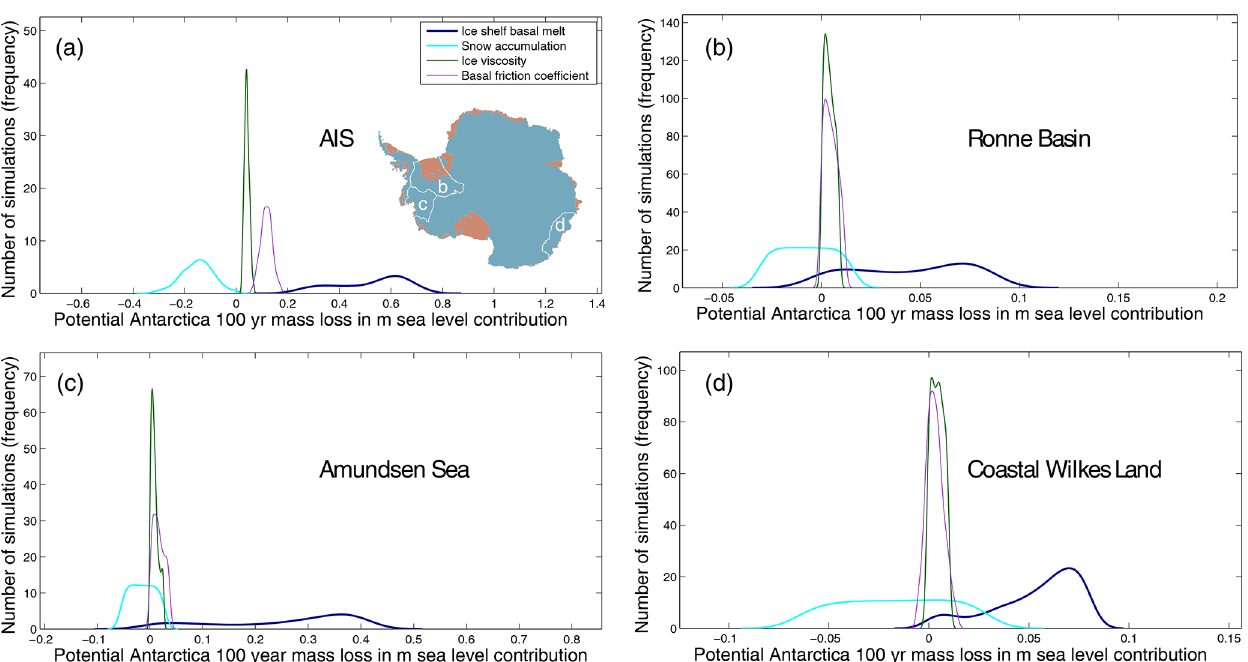
Figure 2. Contribution to uncertainty in 100-year extreme warming simulations of AIS and three subregions of the AIS, tested for four different model variables independently. Each probability distribution function represents an ensemble of 800 ISSM ice-sheet forward model runs, sampled using the DAKOTA uncertainty quantification framework (Schlegel et al.,